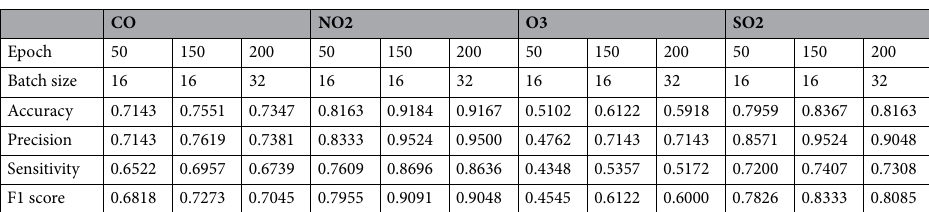
Table 3. Model performance with causal centrality measures used in MLP.